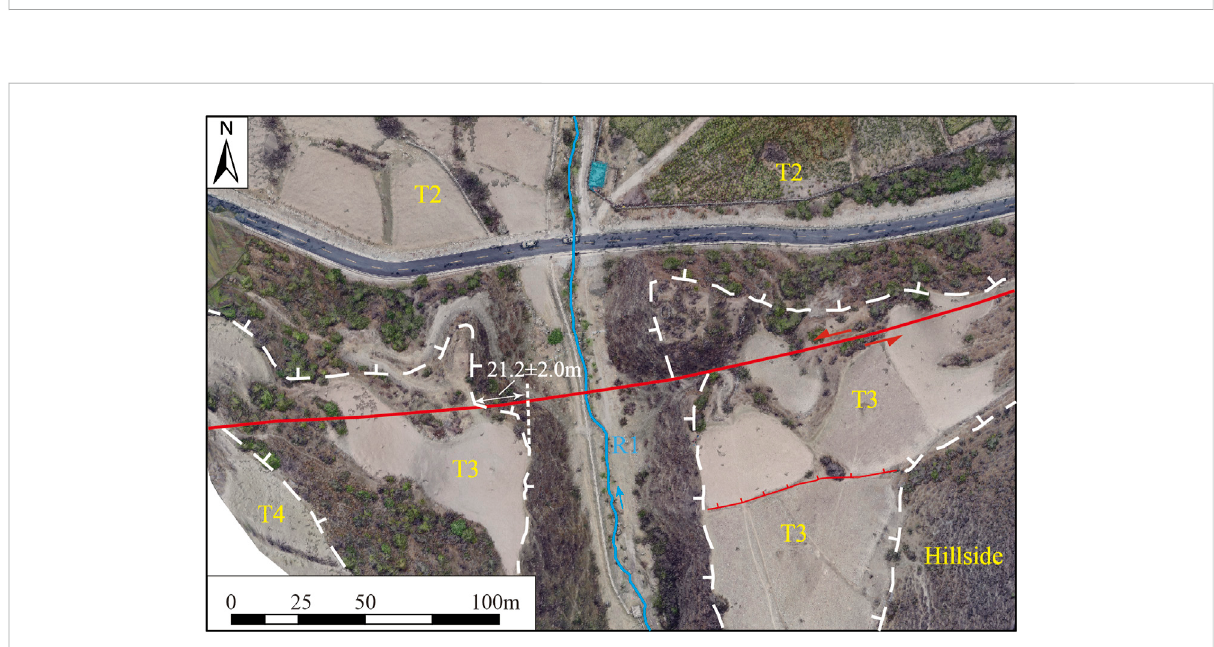
FIGURE 10 Terrace (T3) of the Jinshajiang River left-laterally displaced by the Maisu fault, near Worilong, close to Gangtuo, Xizang Province (E98.51997 ° , N31.71514 ° ). The image was acquired using unmanned aerial vehicle photogrammetry. The white dashed lines represent the terrace riser. R1 is a tributary of the Jinshajiang